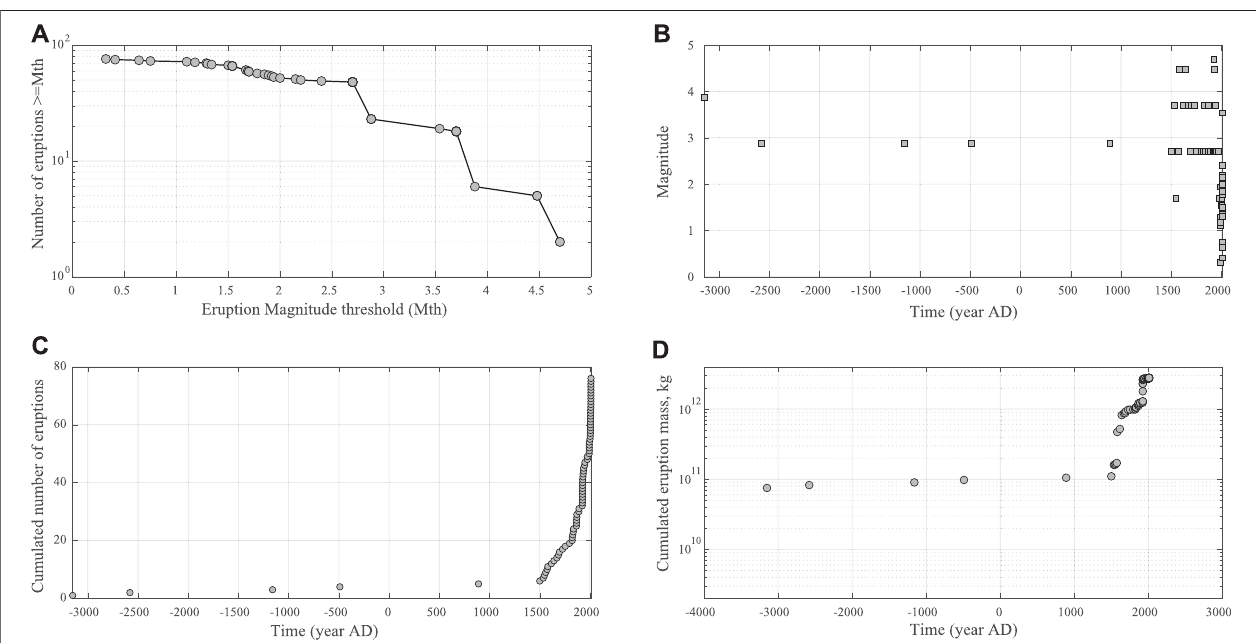
FIGURE 1 | Galeras ’ s new catalog collected, since 3000BP. (A) : the frequency-size plot (B) time series of eruption occurrence and magnitude; (C) Cumulative Distribution Function of onset times of all events in catalog (D) Cumulative erupted mass in time.